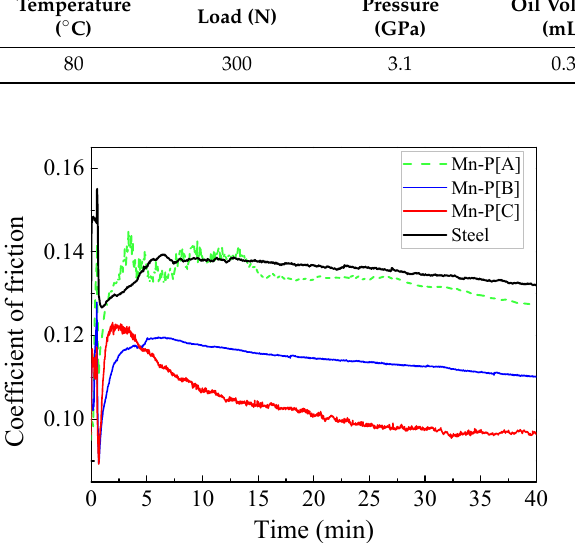
Figure 4. The curve of friction coefficient with different thickness coating.